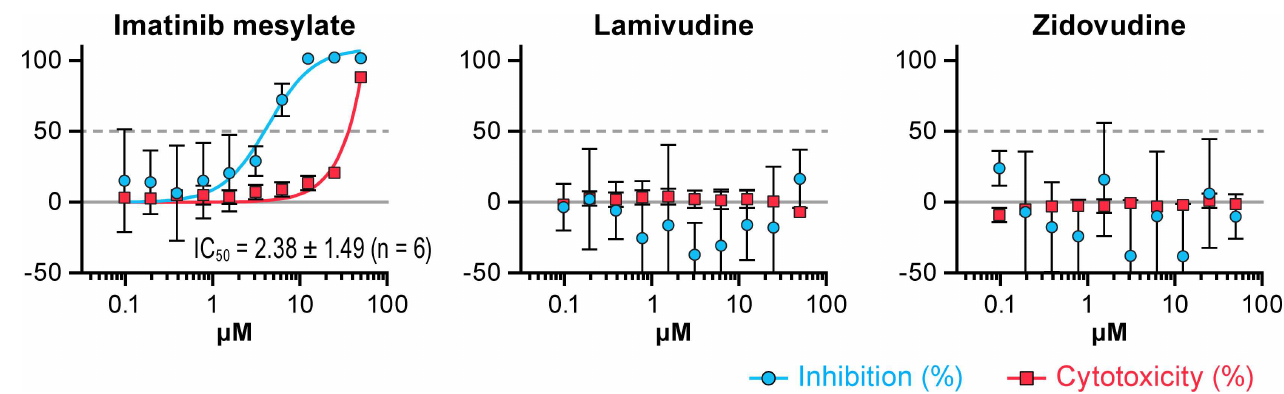
Fig 4. Antiviral activity of lamivudine and zidovudine against EBOV-eGFP virus. Huh 7 cells were pre-treatedwith imatinib mesylate, lamivudine or zidovudinefor 1 h and then inoculatedwith EBOV-eGFP virus at a multiplicityof infection (MOI) of 0.2. Fluorescence was determined at 48 h post-inoculation. Imatinib mesylate was used as a positive control. Antiviral activity is shown in blue and cytotoxicity is shown in red. The experiment was run with a ten-point, two-fold dilutionscheme with quadruplicatewells per